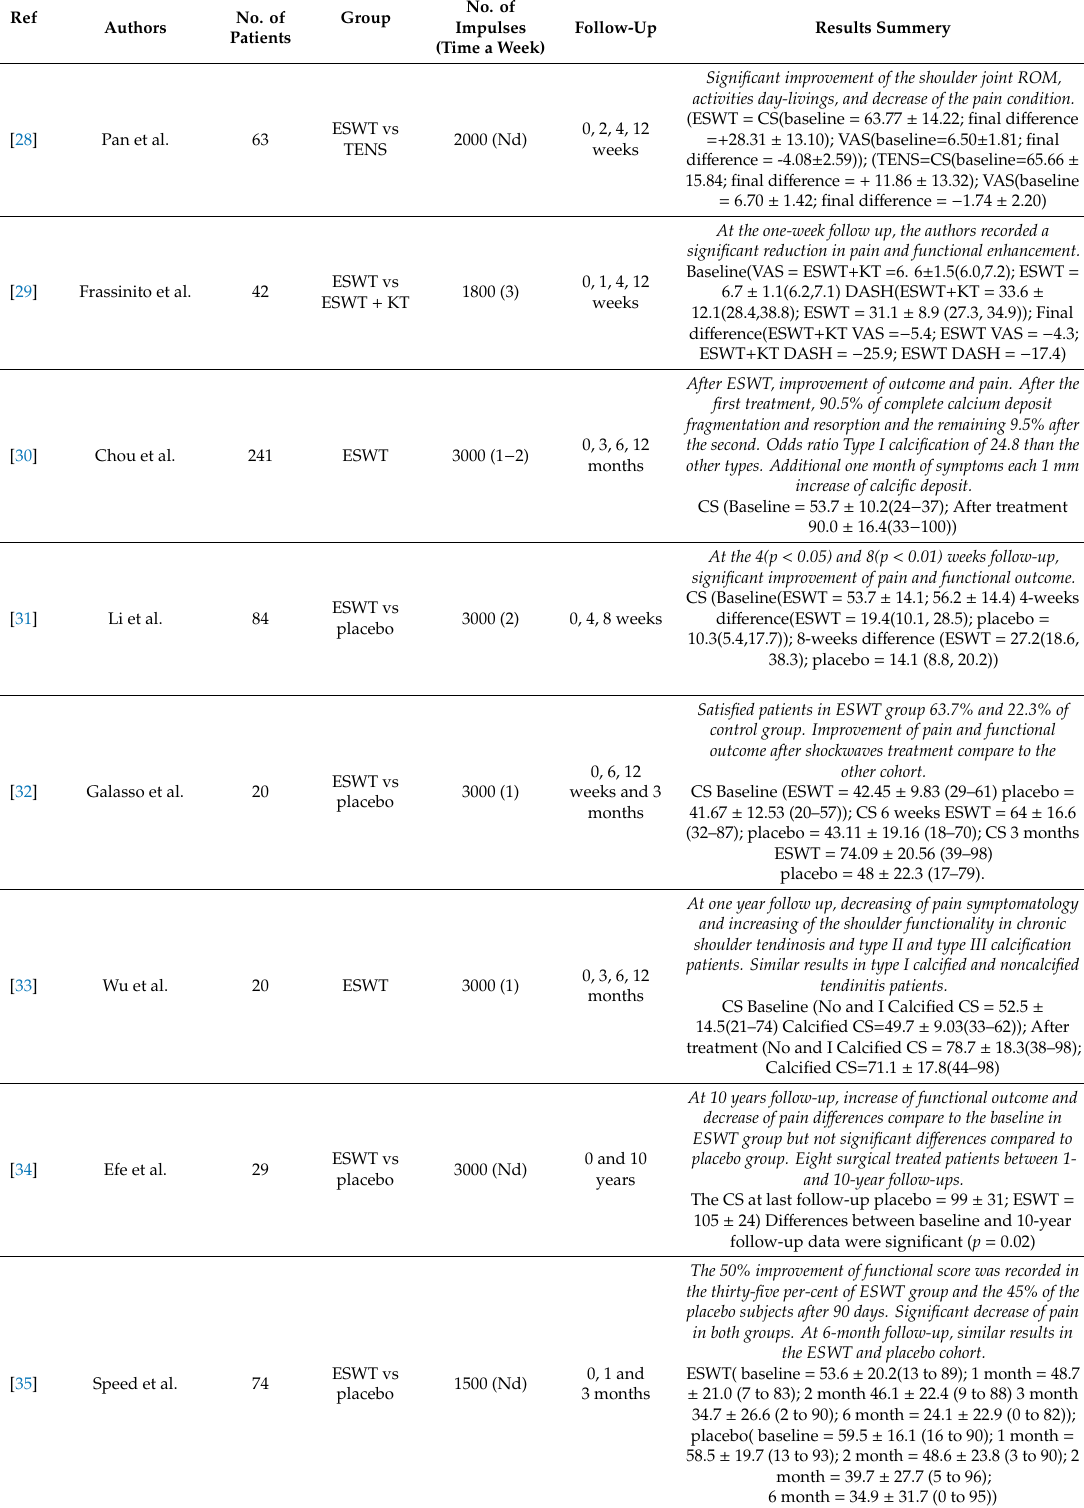
Significant improvement of the shoulder joint ROM, activities day-livings, and decrease of the pain condition. (ESWT = CS(baseline = 63.77 ± 14.22; final di ff erence 0, 2, 4, 12 =+ 28.31 ± 13.10); VAS(baseline = 6.50 ± 1.81; final 2000 (Nd) weeks di ff erence = -4.08 ± 2.59)); (TENS = CS(baseline = 65.66 ± 15.84; final di ff erence = + 11.86 ± 13.32); VAS(baseline At the one-week follow up, the authors recorded a significant reduction in pain and functional enhancement. Baseline(VAS = ESWT + KT = 6. 6 ± 1.5(6.0,7.2); ESWT = 6.7 ± 1.1(6.2,7.1) DASH(ESWT + KT = 33.6 ±